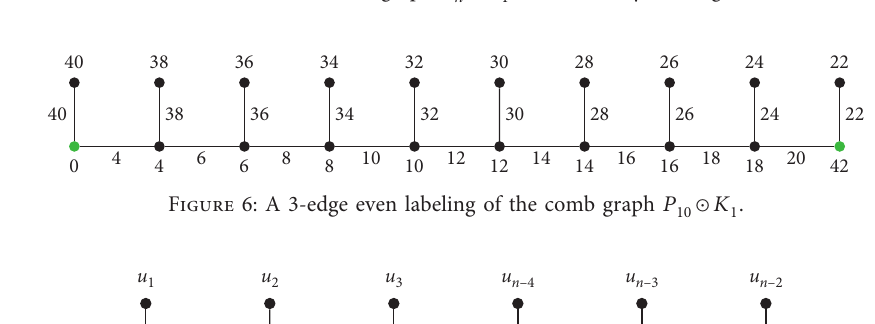
Figure 5: The comb graph P